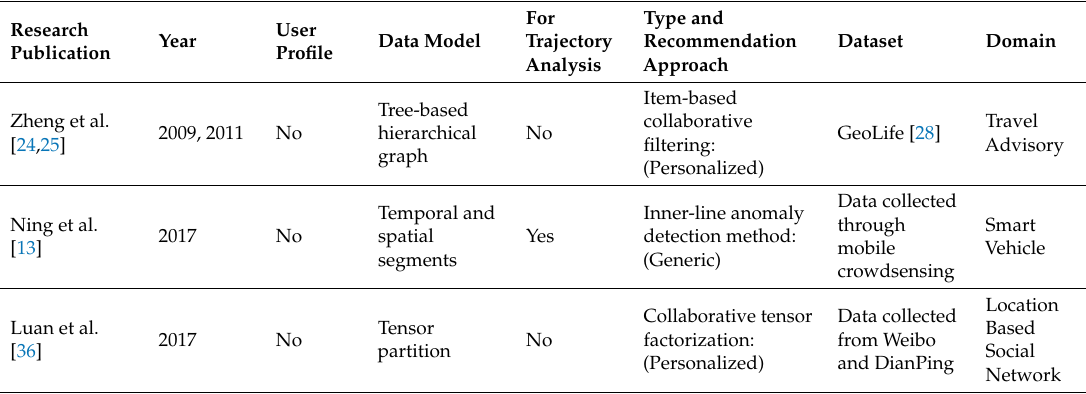
Table 1. Summary of research publications on recommendation approaches in